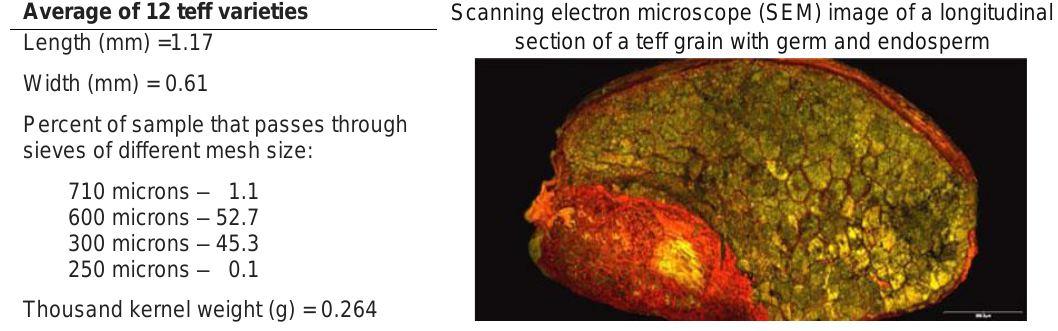
Table 2.1 — Teff grain